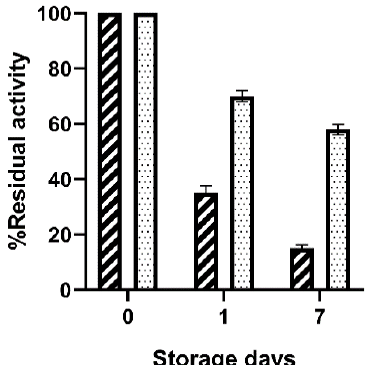
Figure 1. Storage stability at 4 ◦ C of β -Glc entrapped in biomimetic silica with spermidine (Spr) (dots) or β -Glc entrapped in biomimetic silica with poli Lysine (PL) (striped).